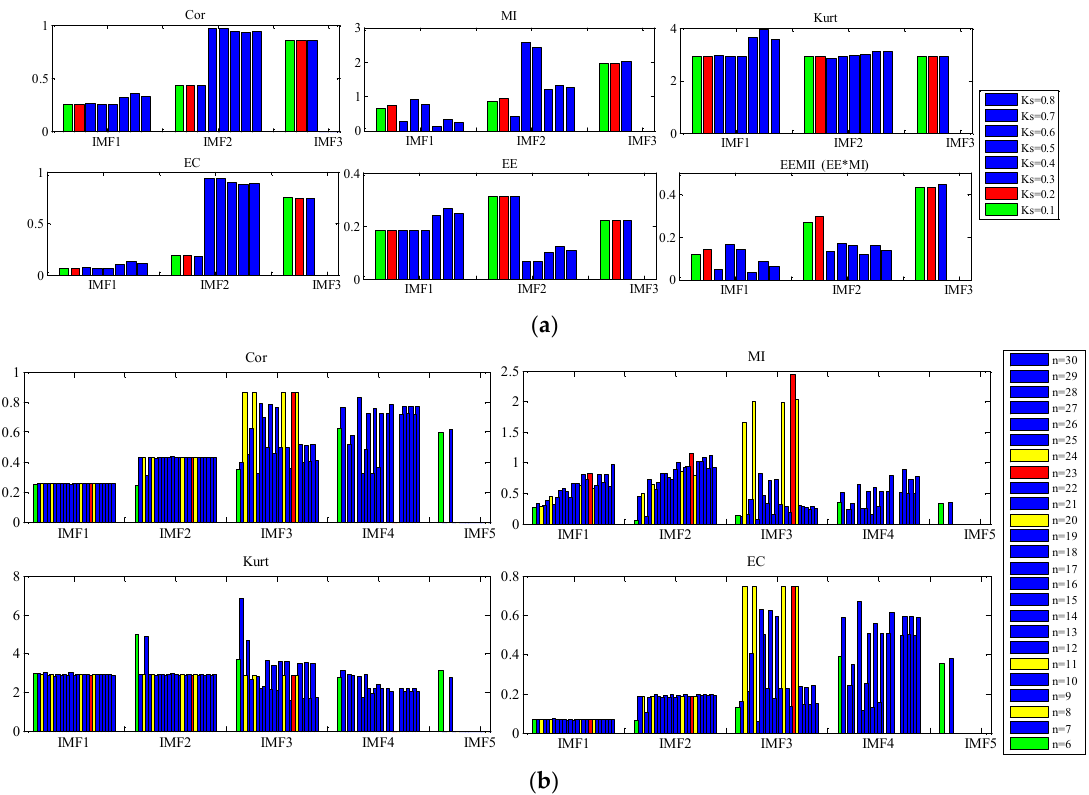
Figure 9. The relationship between the indexes of the IMF and the parameters ( a ) bandwidth threshold ξ , and ( b ) B-spline order n for simulated signal x ( t )